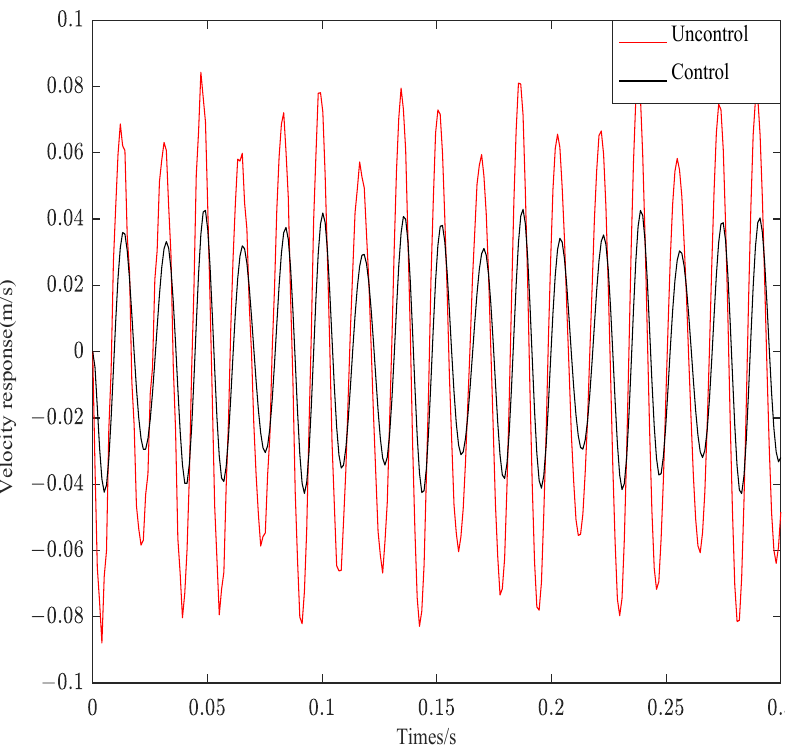
Figure 14. Velocity response under impulse signal. Figure 15 is the response curve of structure 3 under complex aperiodic signal.